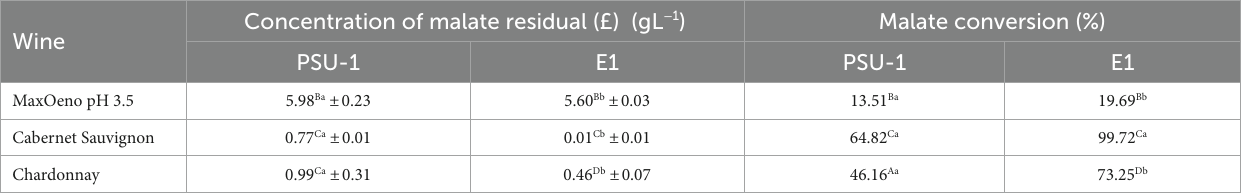
TABLE 2 Malate conversion generated by PSU-1 and E1 strains in different culture conditions ( *